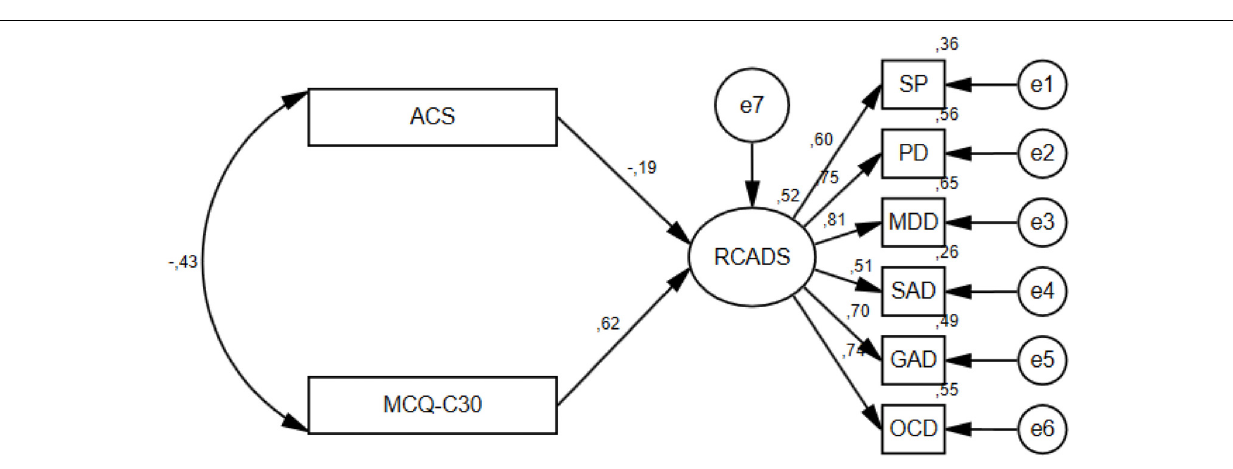
FIGURE 2 | Structure and standardized estimates of the best fitting model in the clinical